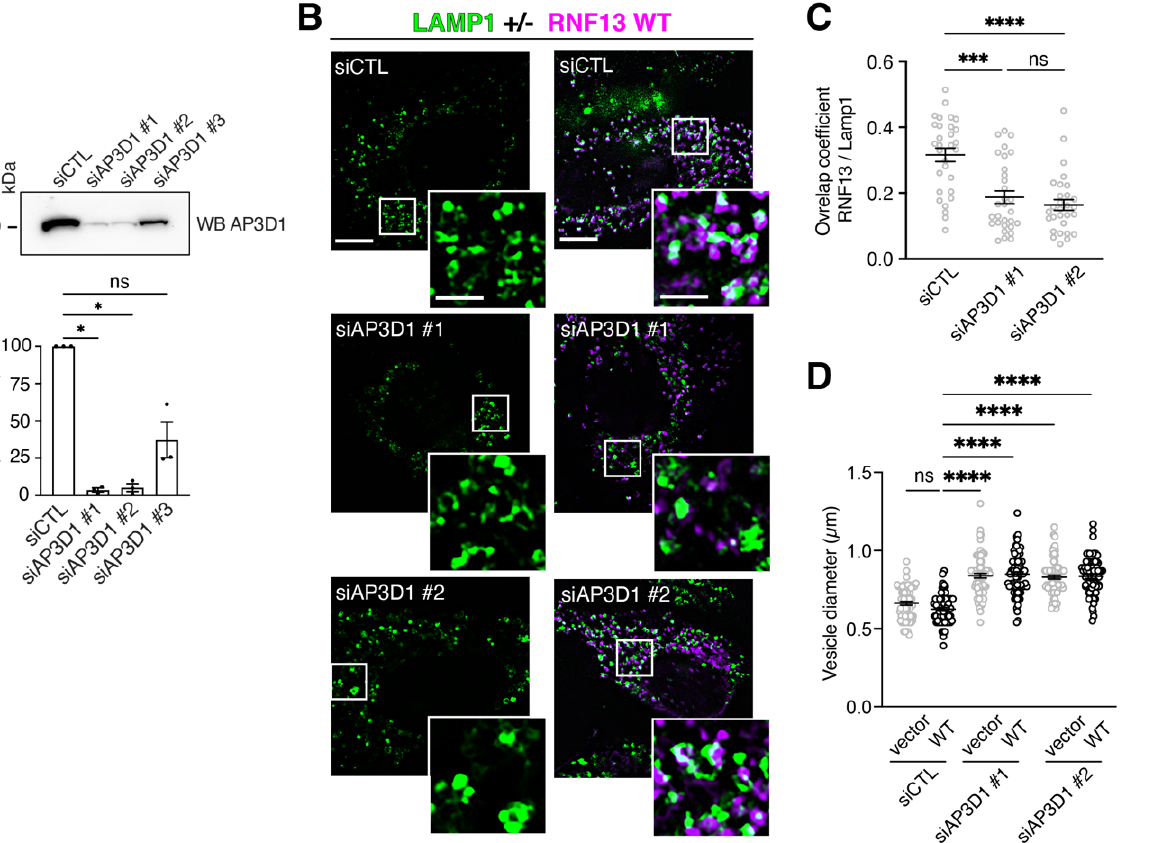
Figure 6. Knockdown of AP-3 interferes with RNF13 localization to lysosomes. ( A ) HeLa cells were transfected using 10 nM of Dicer-substrate siRNAs (DsiRNAs) specific against AP3D1 or nontargeting (siCTL). Three DsiRNAs specific against AP3D1 were tested. Seventy-two hours after transfection, cells were lysed and diluted in Laemmli buffer. Proteins were separated on SDS–PAGE and transferred to a PVDF membrane which was immunoblotted using specific primary anti- body against AP3D1. Band densities were analyzed and normalized to the band density of the siCTL lane using ImageLab software. The bar graph presents the mean ± SEM while the strip plot represents the averaged relative protein abundance of each independent experiment analyzed (N = 3). Not significant (ns) or * p < 0.05 using one-way ANOVA with the Krus- kal–Wallis test. ( B – G ) HeLa were transfected using 10 nM of DsiRNAs #1, #2 or siCTL for 72 h. Twenty-four hours prior to fixation, cells were transfected with either a plasmid construct encoding HA-tagged RNF13WT or an empty vector. Cells were fixed, permeabilized, and labeled with specific primary antibody against HA (RNF13) and against the endog- enous subcellular markers. Representative images from three independent experiments (N = 3) show RNF13-HA (in pur- ple) and ( B ) lysosome marker Lamp1 and ( E ) late endosome marker Rab7 (in green). Scale bars indicate 10 µm for whole- cell image and 2 µm for the boxed area shown at higher magnification. The jittered individual value plots ( C , F ) represent the Manders coefficient of RNF13 over ( C ) Lamp1 or ( F ) Rab7. For each condition analyzed: N = 3, n = 30 cells. Values are